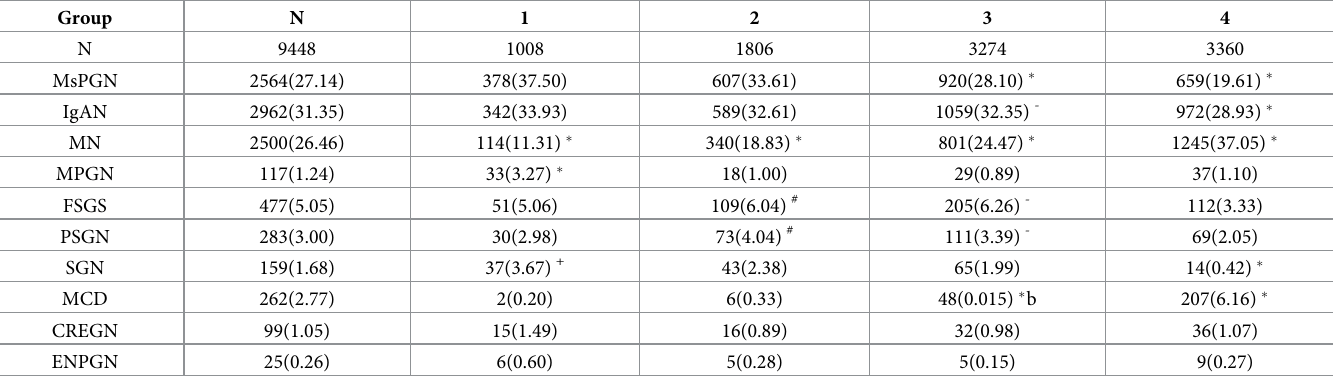
Table 5. Comparison of pathological types in each group.